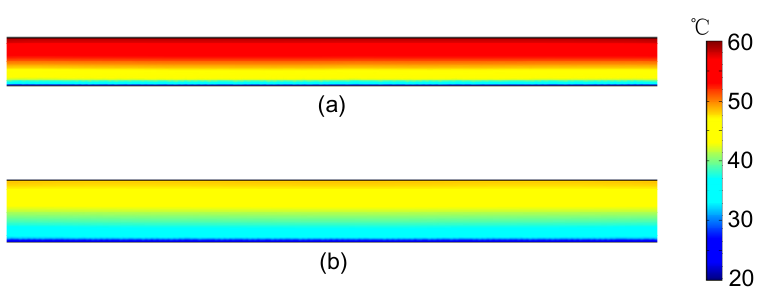
Figure 10. Potential distributions of contact plane: ( a ) w/o and ( b ) w/ optimization.